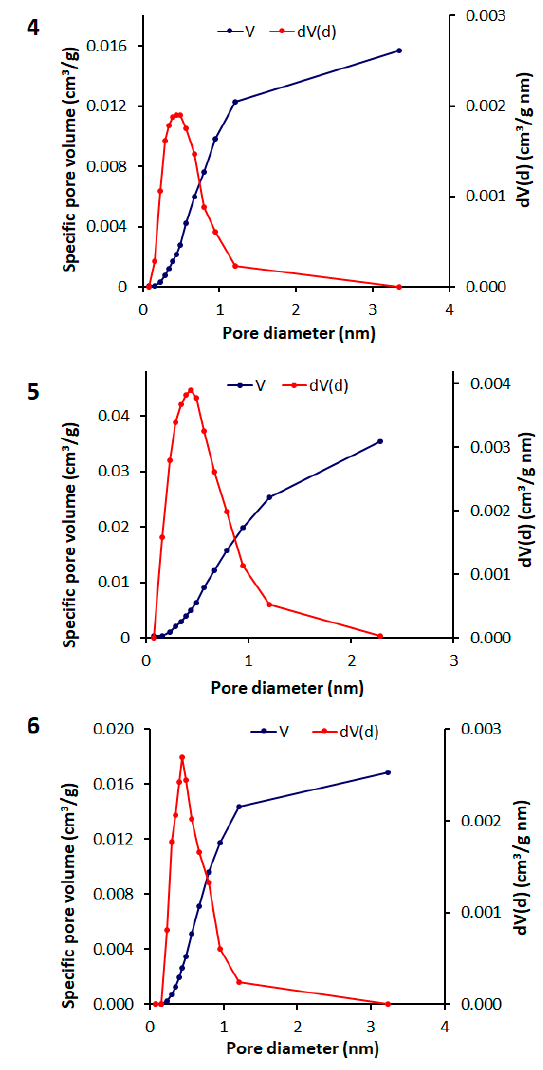
Figure 5. Pore size distribution isotherms of polymers 4–6 .